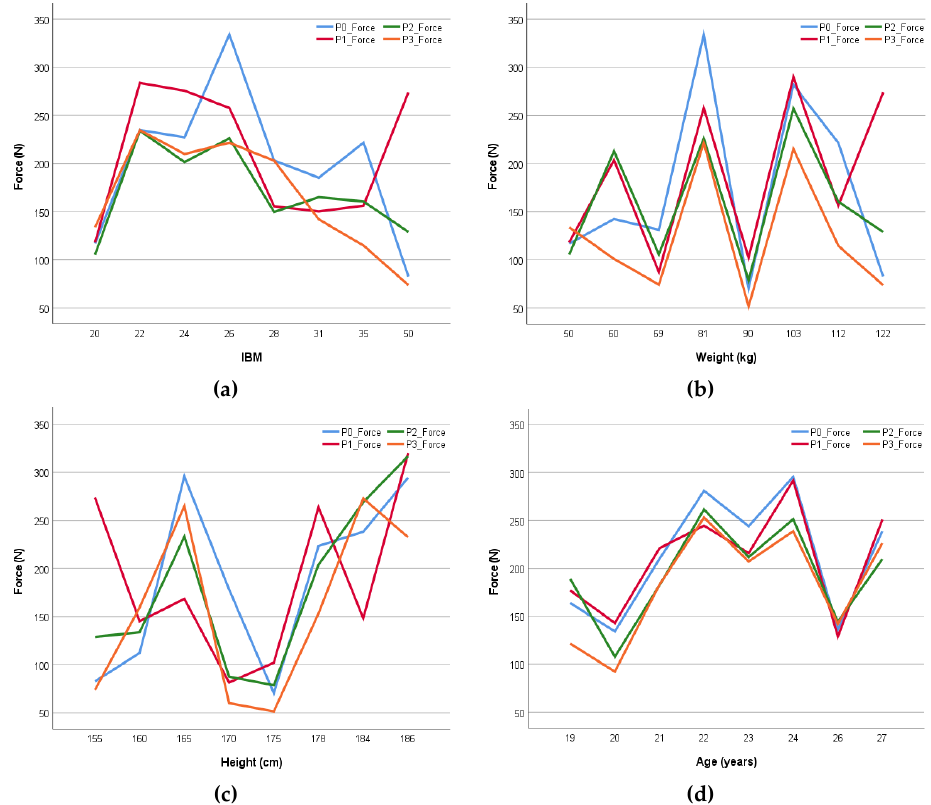
Figure 19. Graphical visualisation of force against some biometric data: ( a ) Force—IMC; ( b ) Force— Weight; ( c ) Force—Hight; ( d )